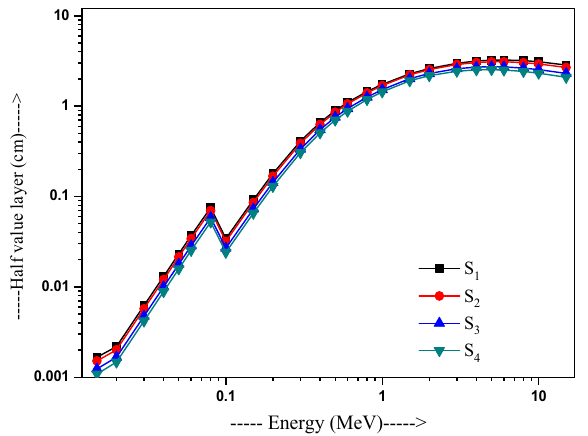
Figure 6. Variation of the half-value layer with energy in 20Bi 2 O 3 − xPbO − (80 − 2x)B 2 O 3 − xGeO 2 (x = 5, 10, 20, and 30 mol%) glasses.